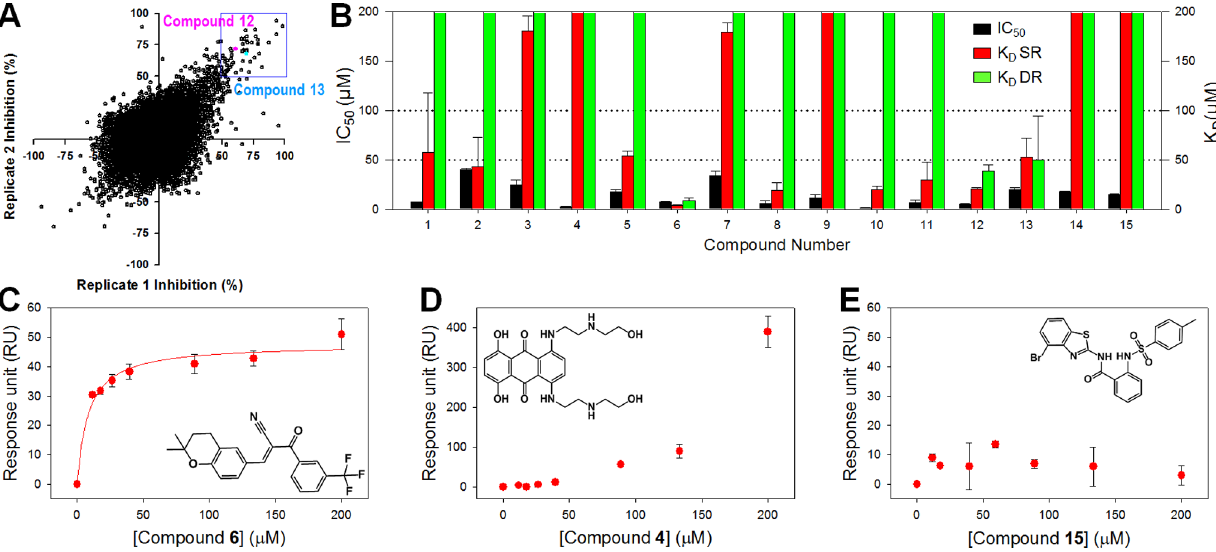
Figure 2. Primary HTS results and SPR validation binding assay results. ( A ) Replicate plot of the screening of 40,967 compounds from structurally diverse in-house, Prestwick FDA-approved drug, Maybridge, and Life Chemicals libraries. The blue box indicates hit compounds with over 50% inhibition at 50 m M compound concentration. Initial percent inhibitions of the two confirmed hits are shown in pink (Compound 12 ) and cyan (Compound 13 ). ( B ) Bar graphs of IC 50 values and the dissociation equilibrium constants (K D ) of 15 initial hit compounds. K D SR is single referenced K D values with a blank channel immobilized with a small molecule ethanolamine, whereas K D DR represents double referenced with ethanolamine and an unrelated reference protein ( B. anthracis PyrC, , 95 kDa as a dimer) immobilized in two different channels. All data were normalized for immobilization levels of target and reference proteins. Bars that reached the top of the graph represent K D values of over 200 m M (no binding). ( C ) The fitting curve of compound 6 with a single rectangular hyperbolic equation (See methods). The determined K D of compound 6 was 8.3 6 1.9 m M, similar to its IC50 value (7.6 6 0.6 m M). ( D ) Response units of compound 4 (mitoxantrone from the Prestwick) at a series of increasing concentrations (0–200 m M), showing a non-specific binding pattern. ( E ) Response units of compound 15 at various concentrations (0–200 m M), showing lack